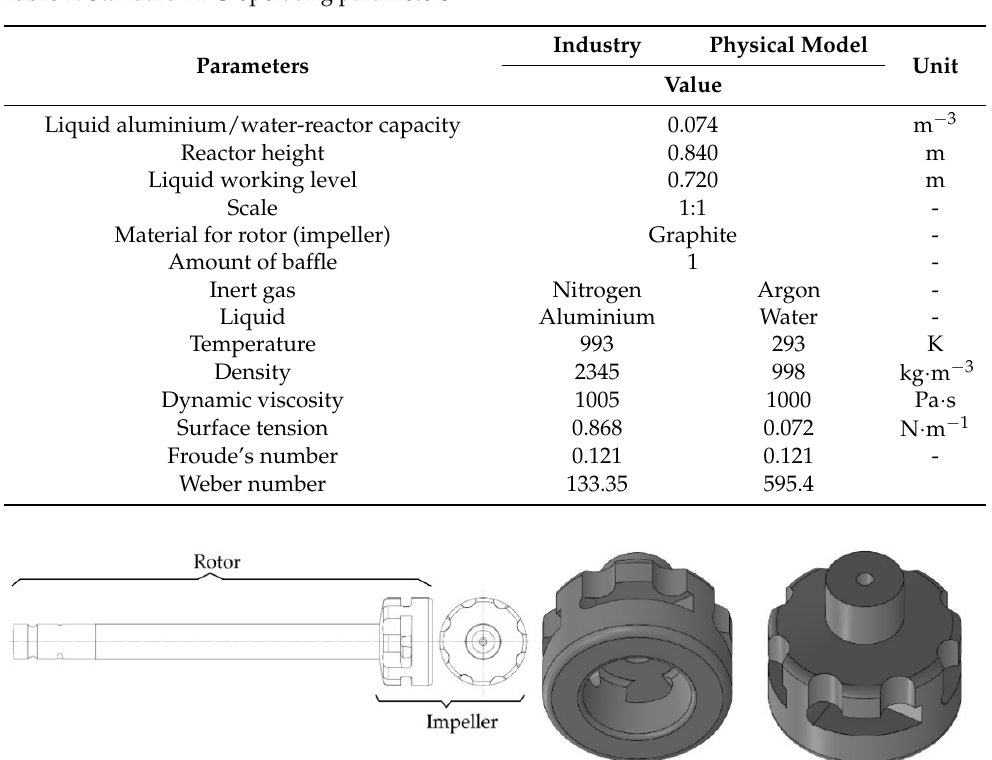
Table 1. Standard FDU operating parameters.